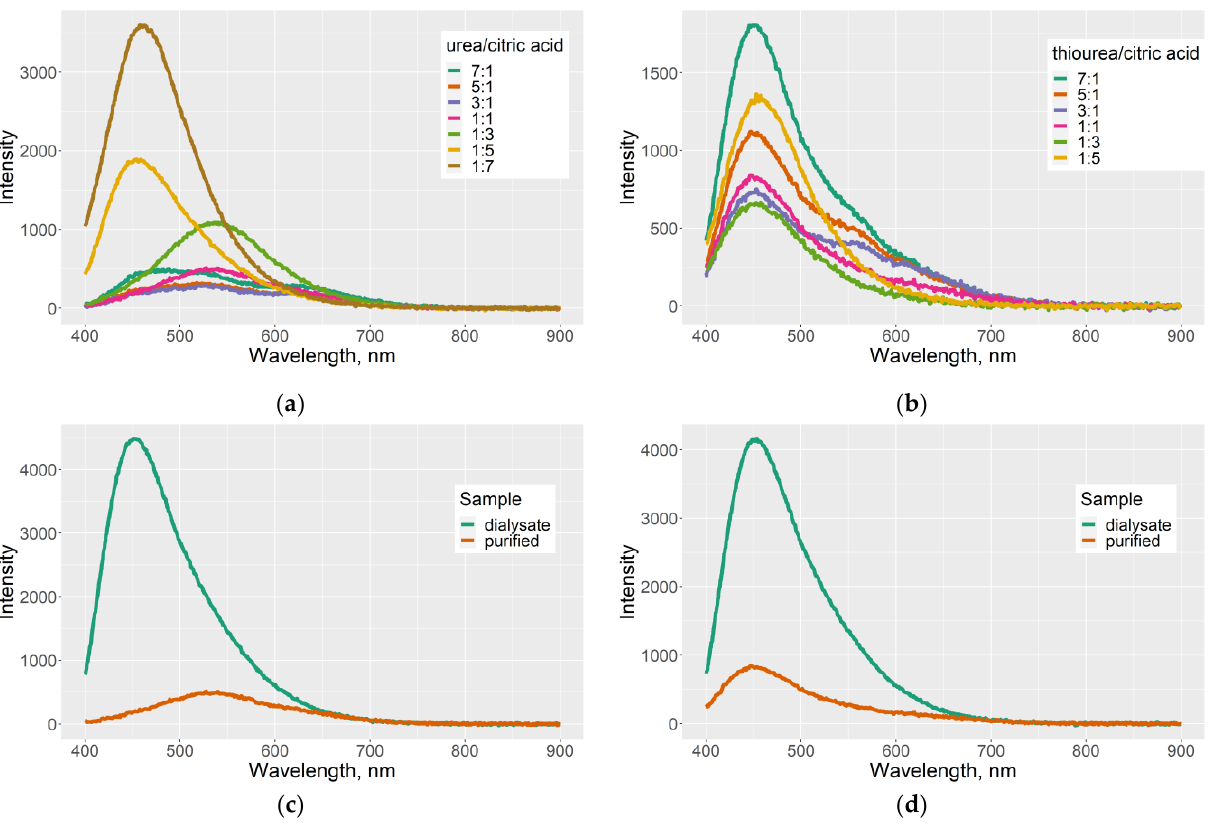
Figure 6. Emission spectra of the purified samples (excitation wavelength 365 nm) ( a , b ) and com- parison of emission spectra of the dialysates and purified samples ( c , d ). ( a ) Purified products of solvothermal treatment of mixtures of urea with citric acid (the mixture composition is given in the legend); ( b ) Purified products of solvothermal treatment of mixtures of thiourea with citric acid (the mixture composition is given in the legend). Initial mixture composition: ( c ) urea/citric acid = 1:1; ( d ) thiourea/citric acid = 1:1.